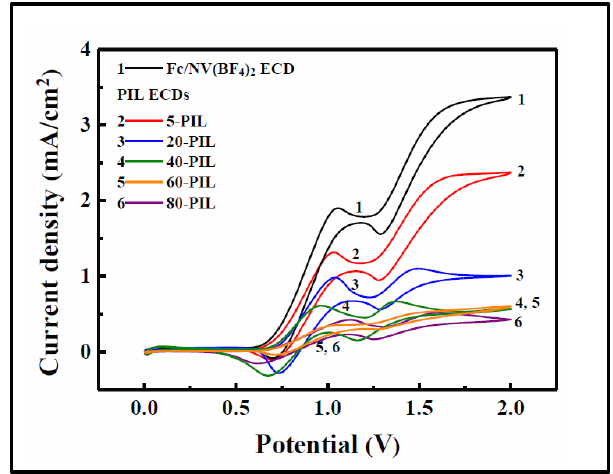
Figure 5. Cyclic voltammograms (CVs) of ECDs based on liquid electrolyte free of poly(ionic liquid) (PIL) (Fc/NV(BF 4 ) 2 ) and those registered for PIL-based ECDs with different amounts of PIL (from 5 to 80 wt.%) at a scan rate of 50 mV/s. (ITO glass, homemade Ag/Ag + , and Pt were employed as the working, reference, and counter electrode, respectively.) Reprinted with permission from [96], copyright (2016) American Chemical Society.